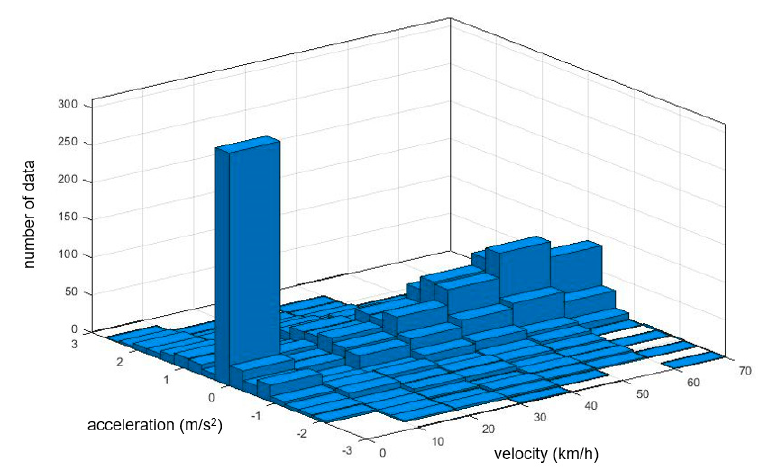
Figure 4. Exampled speed and acceleration distribution for urban part of road.